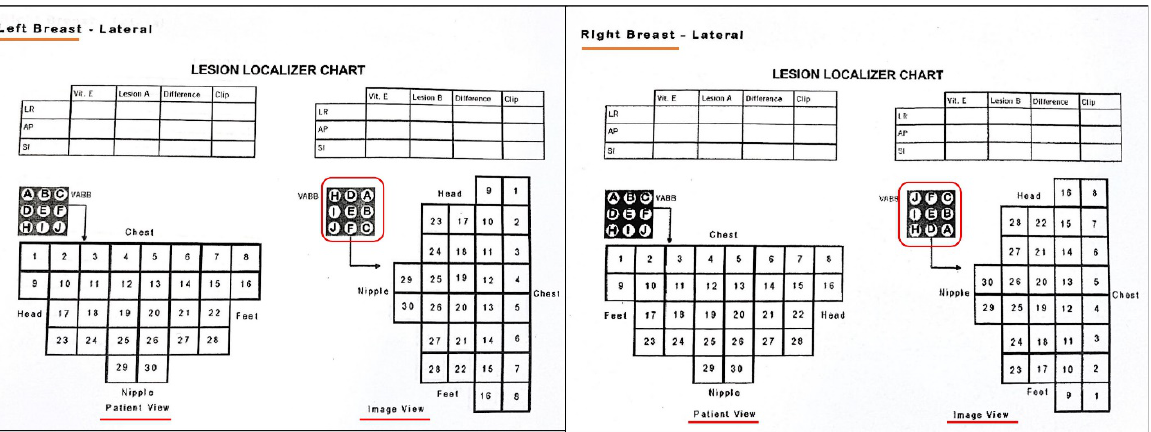
Figure 10. Examples of the charts used for manual targeting during MRI breast biopsy. Please note that location of various co-ordinates differs with the laterality and approach used for the case. Trans- lation of the target from image view to patient view is also a critical step and a mistake in this may lead to wrong targeting.